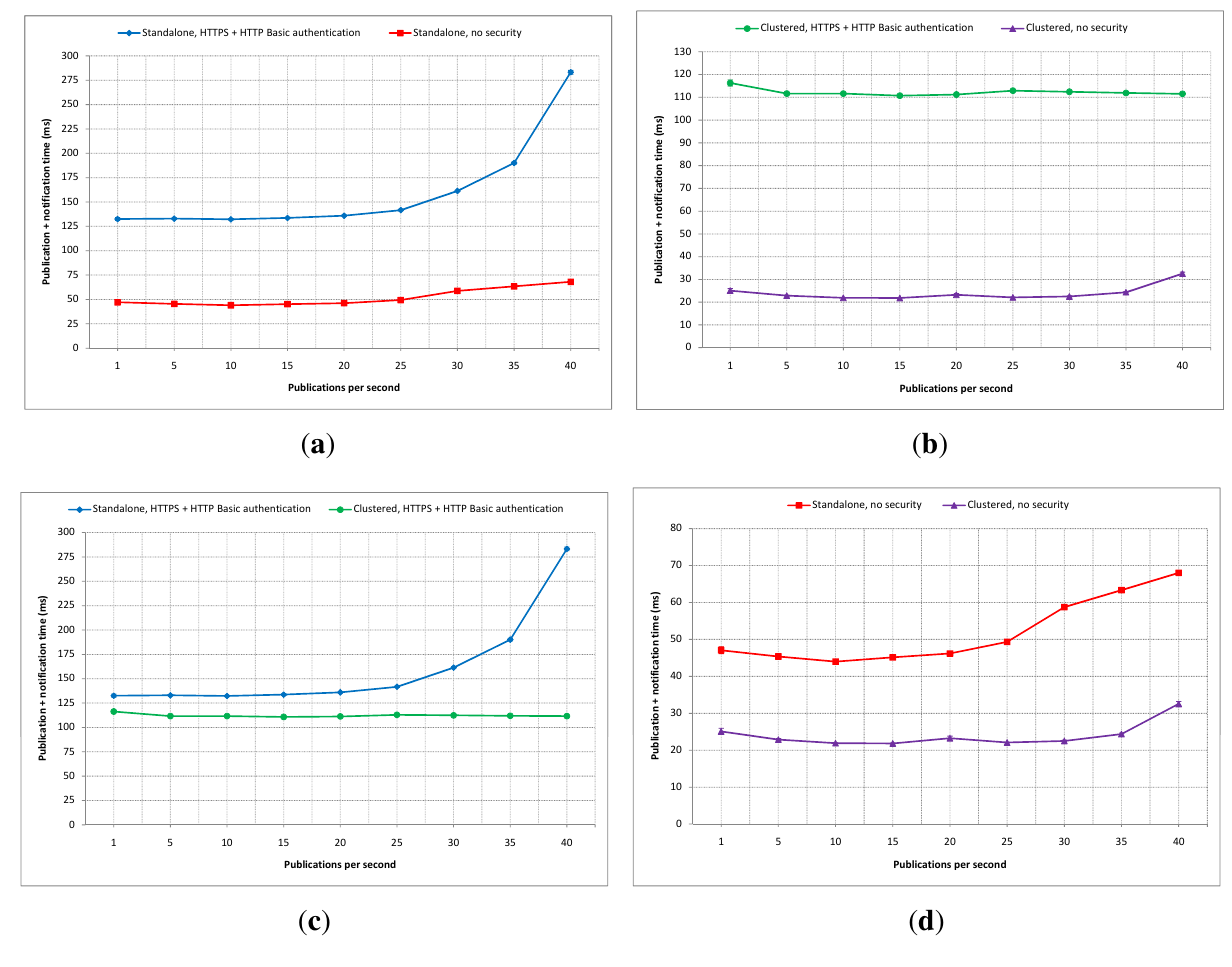
Figure 18. Publication and notification time comparisons with publication rate as variable: ( a ) Standalone secure vs . insecure; ( b ) Clustered secure vs . insecure; ( c ) Secure standalone vs . clustered; ( d ) Insecure standalone vs .